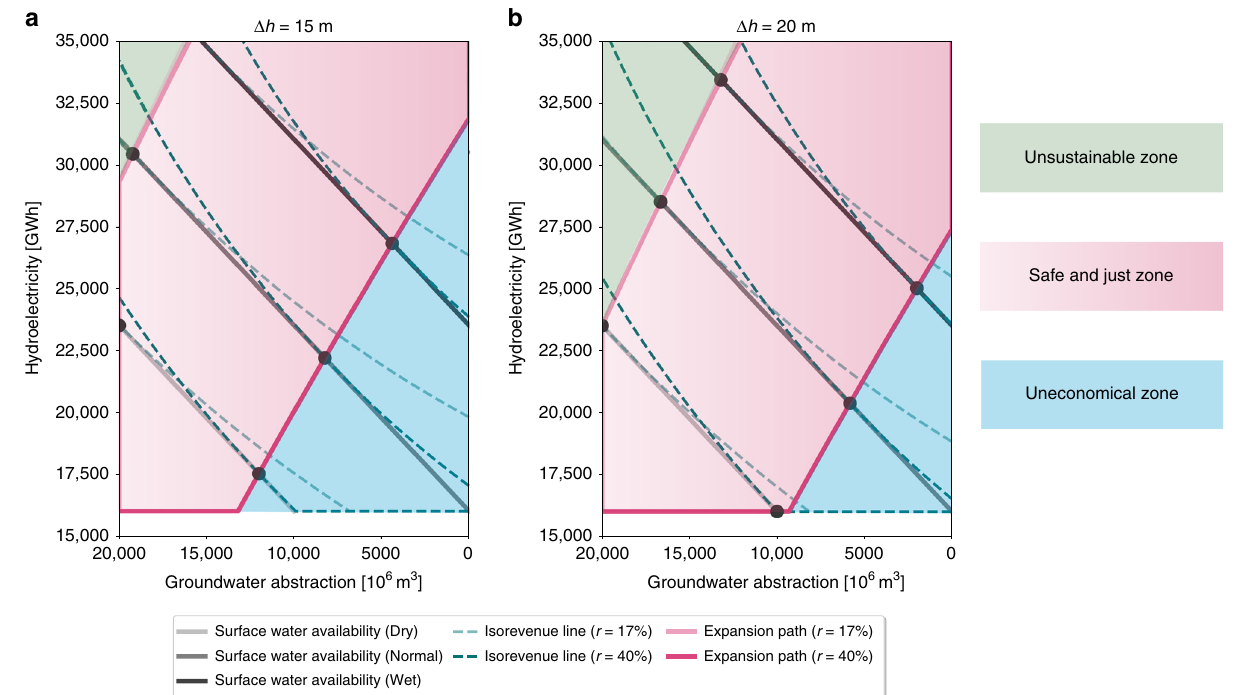
Fig. 1 Trade-off analysis between groundwater abstraction and hydropower generation. Frontiers curves (gray solid lines) for three in fl ow availability conditions (dry, normal and wet year) during the historical period estimated from CWatM, the corresponding iso-revenue lines (green dashed lines) and expansion paths (pink solid lines) for optimal water allocation given current ( r = 17%) and future penetration of SWE ( r = 40%) under different groundwater pumping lift ( Δ h ): a Δ h ¼ 15 m , b Δ h ¼ 20 m . Black dots represent the optimal condition, where surface water allocation is ef fi cient and revenue can be maximized. Light-green shaded area represents unsustainable zone, where more groundwater is abstracted for irrigation as less surface water is available due to its use for hydroelectric generation. Pink shaded area is the safe and just zone, where optimal points can be achieved. Light-blue shaded area represents uneconomical zone, where we sacri fi ce the revenue from hydropower production in order to maintain the groundwater